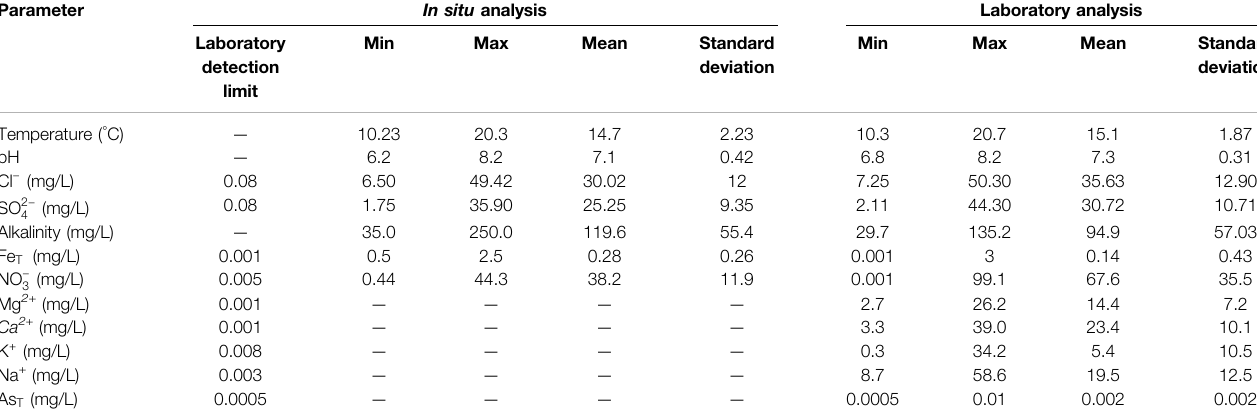
TABLE 3 | Average physicochemical parameters for data sampled from well water recorded by volunteers and researchers from the Boca Itata community.